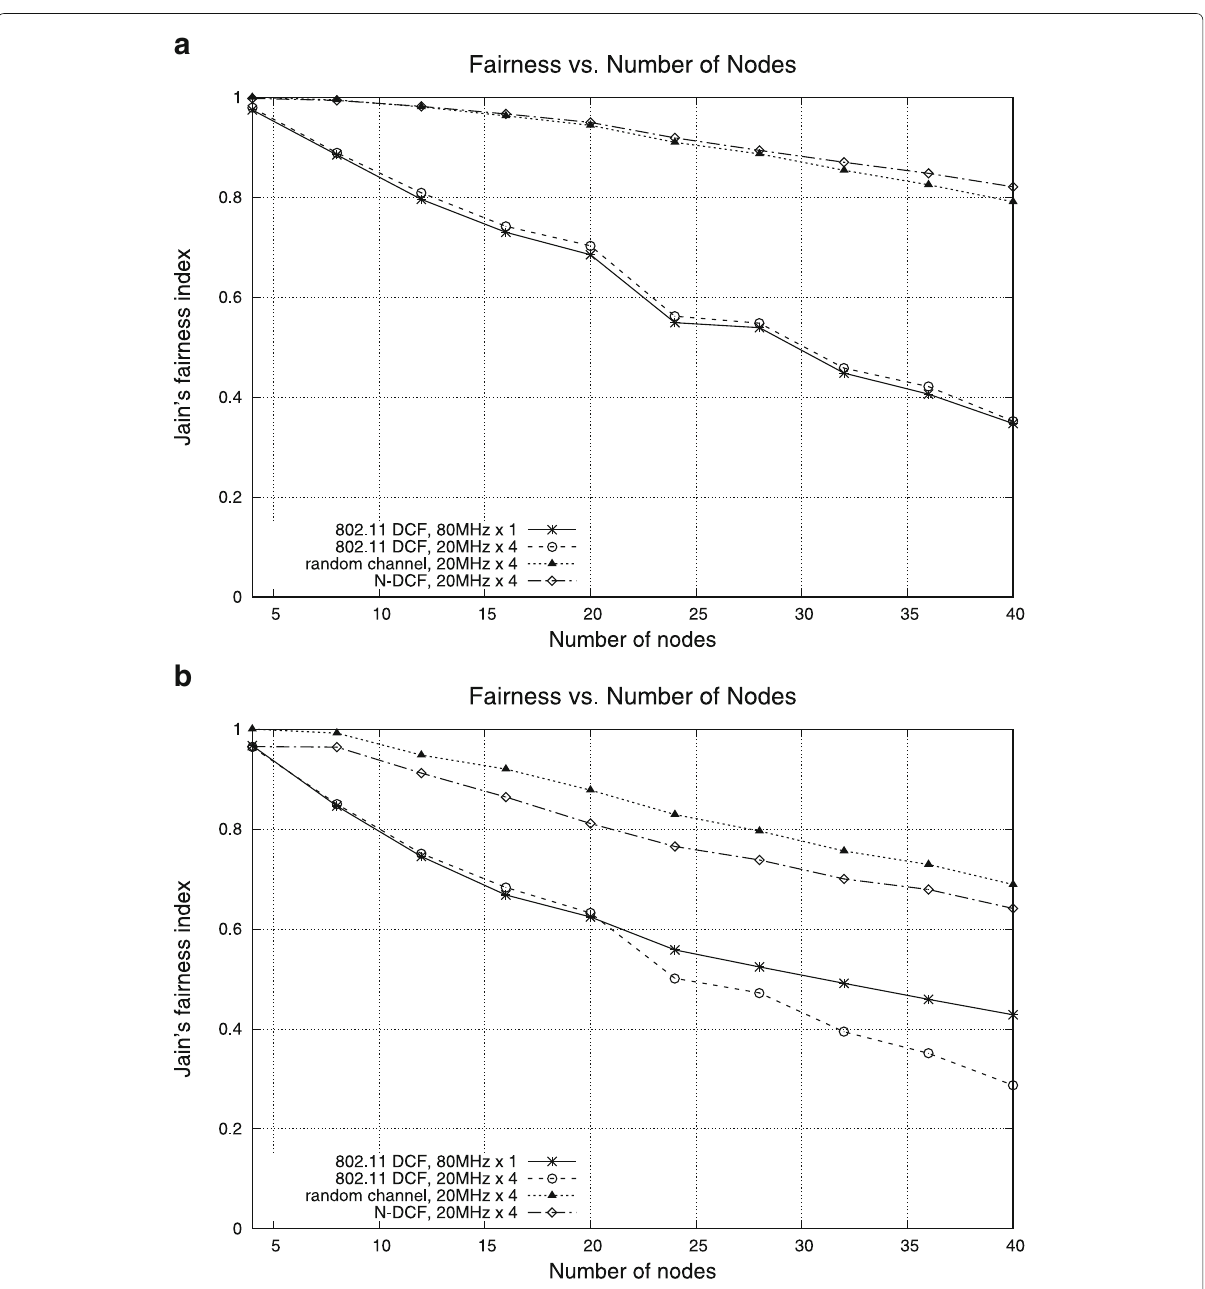
Fig. 17 Jain’s fairness index varying number of nodes for an ad hoc network. a A-MPDU size = 3000 bytes, b A-MPDU size = 65,535